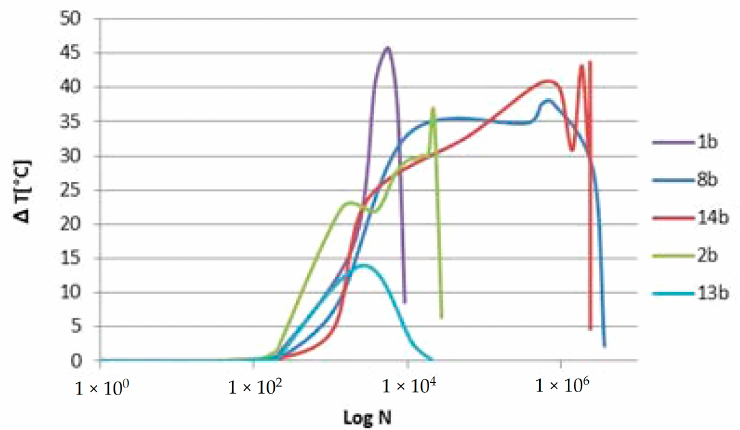
∆ T as a function of the number of